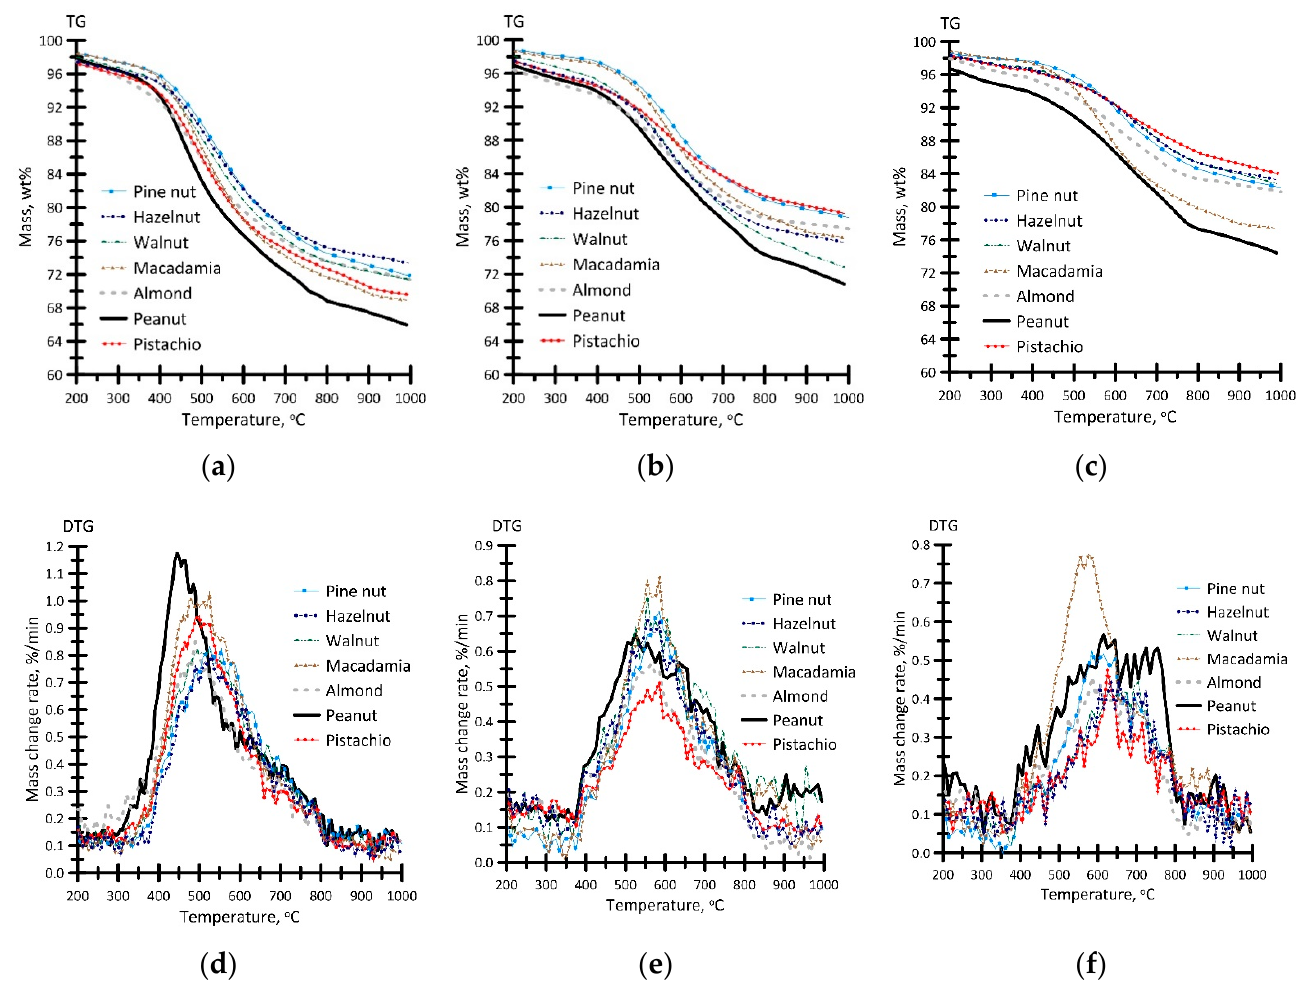
Figure 8. TG ( a – c ) and DTG ( d – f ) curves for the process of thermal decomposition of the biochar samples produced at different temperatures: ( a ,d)—400 °C, ( b , e )—500 °C, ( c , f )—600 °C. Argon flow rate—150 mL/min, heating rate—10 °C/min, sample weight ≈ 15 mg.